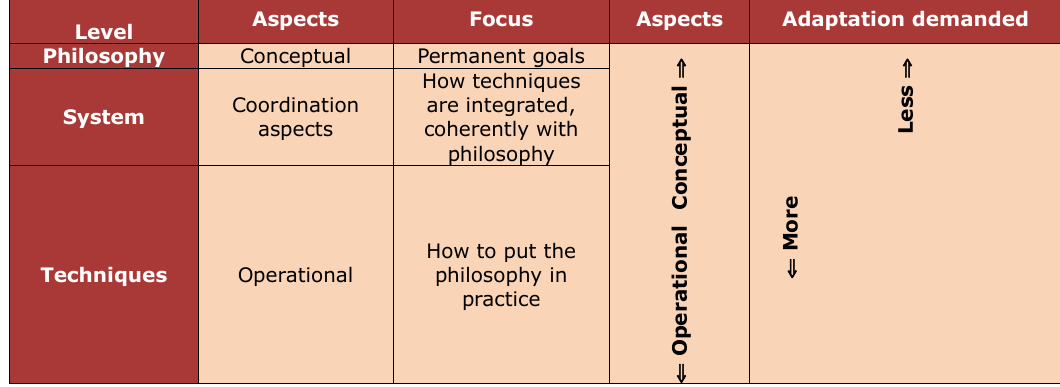
Table 1. Lean Thinking: Philosophy, system, and techniques (Picchi, 2001)